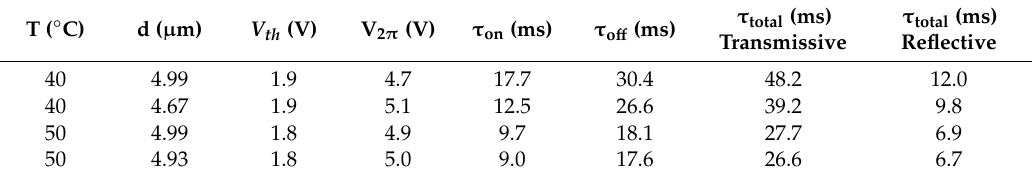
Table 3. Measured response time of a transmissive TL-216 cell with d = 4.99 µ m, and the extrapolated response time to the corresponding reflective cells at 40 ◦ C and 50 ◦ C. λ = 633 nm.